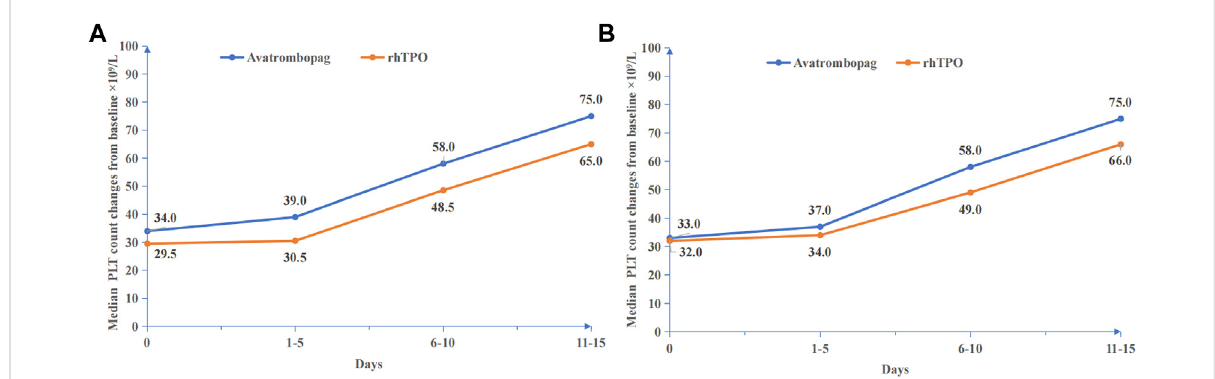
FIGURE 2 Platelet count changes before and after medication. (A) Before PSM, median PLT count changes from baseline ×10 9 /L. (B) After PSM, median PLT count changes from baseline ×10 9